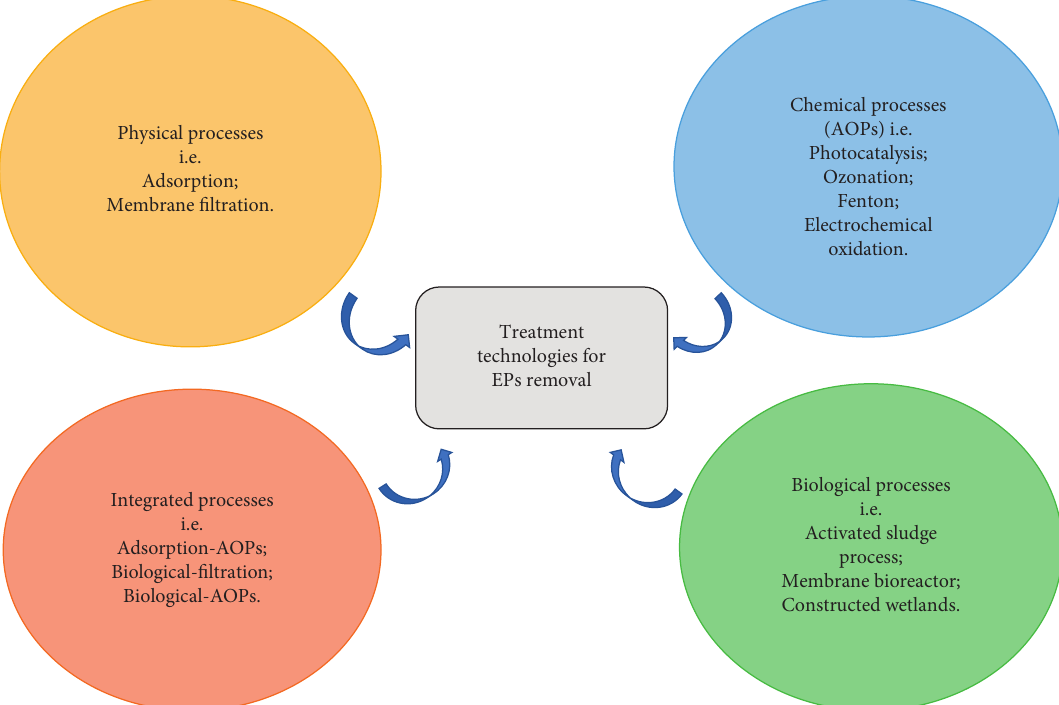
Figure 4: Common treatment technologies for EP